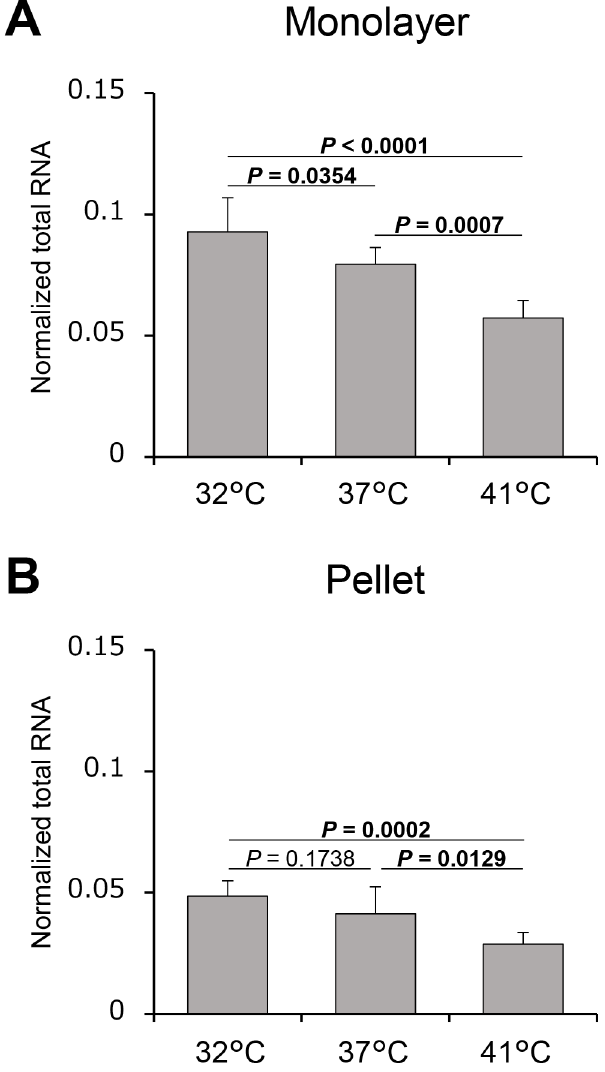
Fig 2. Normalized total RNA. Normalized total RNA at three different culture temperatures was estimated in monolayer (A) and pellet (B) culture systems. Values are expressed as the mean ± standard deviation. n = 8 dishes or pellets/group. Significantly different values ( P < 0.05) are written in